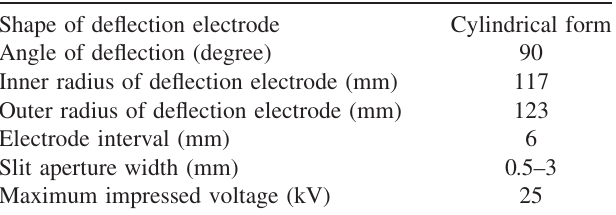
TABLE XII. Capabilities of electrostatic analyzer. Shape of deflection electrode